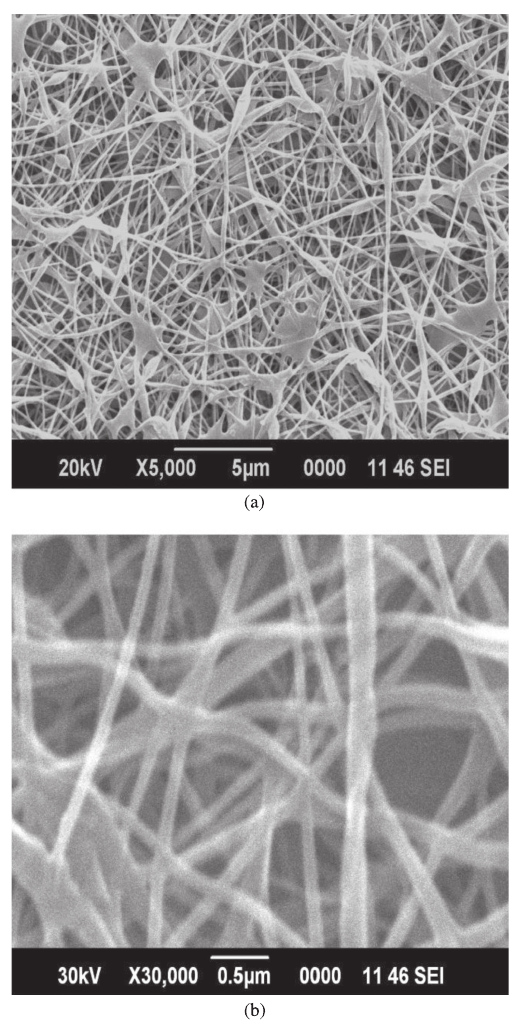
Figure 2. Scanning electron micrograph of electrospun PVA nano fibers at different magnifications (5 µ m and 0.5 µ m).